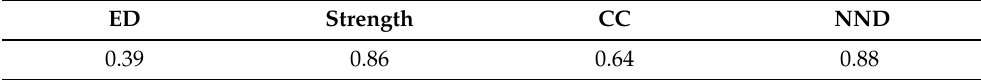
Table 3. Mean correlation of each indicator with the number of aircraft.